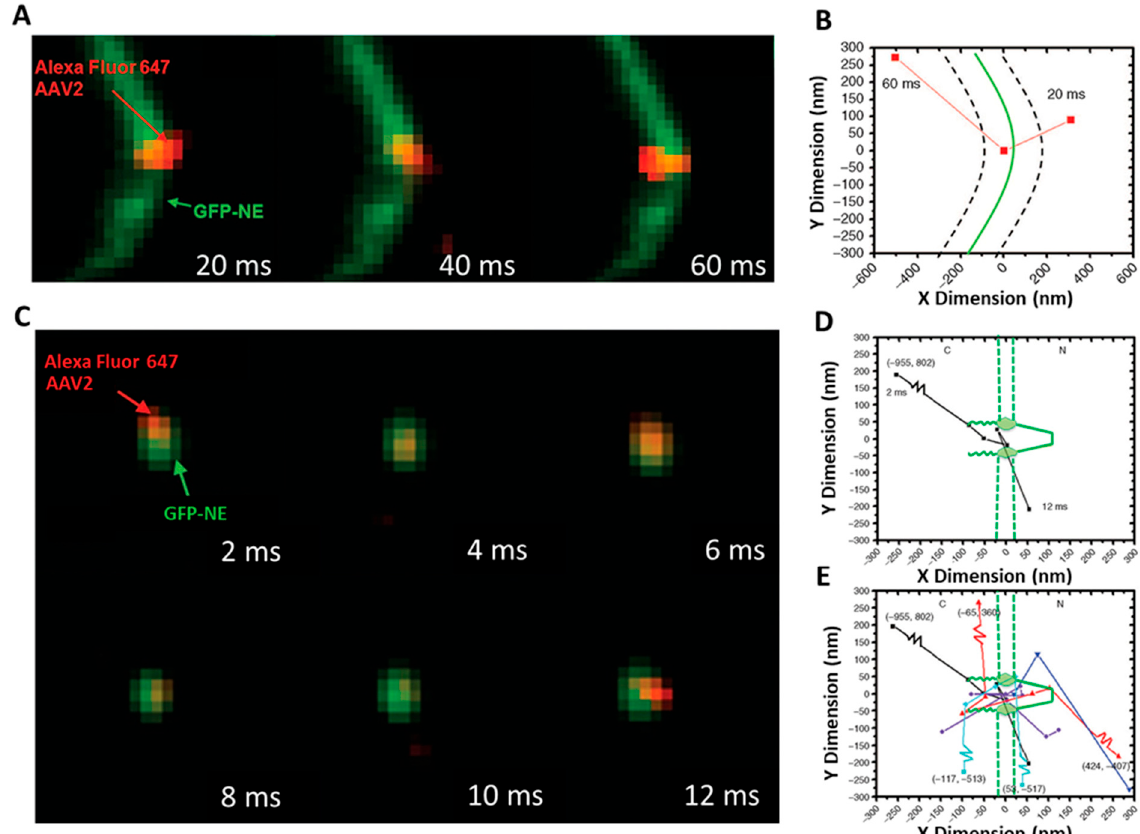
Figure 5. Single-molecule trajectories and 2D spatial locations of AVV2 on the NE and in a single NPC [33]. ( A ) A typical successful single-AVV2 import event captured by wide-field microscopy with a 12 µ m illumination area. A single Alexa Fluor 647-labeled AAV2 particle (red spot) started from the cytoplasm, interacted with the GFP-fused NE (green line), and arrived in the nucleus. ( B ) Single-particle tracks (red squares) were acquired by 2D Gaussian fitting to point spread functions in a series of images. The green curve shows the determined position of the middle plane of the NE. The dotted lines indicate − 100 and +100 nm from the middle plane of the NE. ( C ) A typical successful single-AAV2 import event captured by SPEED microscopy. A single Alexa Fluor 647-labeled AAV2 particle (red spot) started from the cytoplasm, interacted with a single GFP-fused NPC (green spot), and arrived in the nucleus. ( D ) Single-particle tracks (black squares) and the location of the NPC were acquired by 2D Gaussian fitting to point spread functions in a series of images. ( E ) Compilation of several trajectories (shown in different colors) representing AAV2 particles successfully importing to the nucleus from the cytoplasm through single NPCs. C, cytoplasmic side of the NPC; N, nucleoplasmic side of the NPC. Figures were adapted from our previous publications with permission [33].